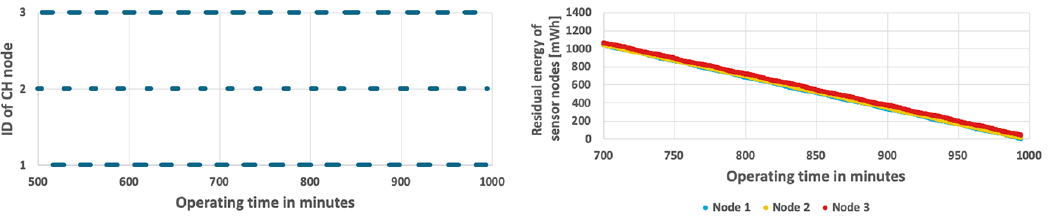
Figure 12. Energy consumption by sensor nodes for the proposed algorithm with a variable number of detected